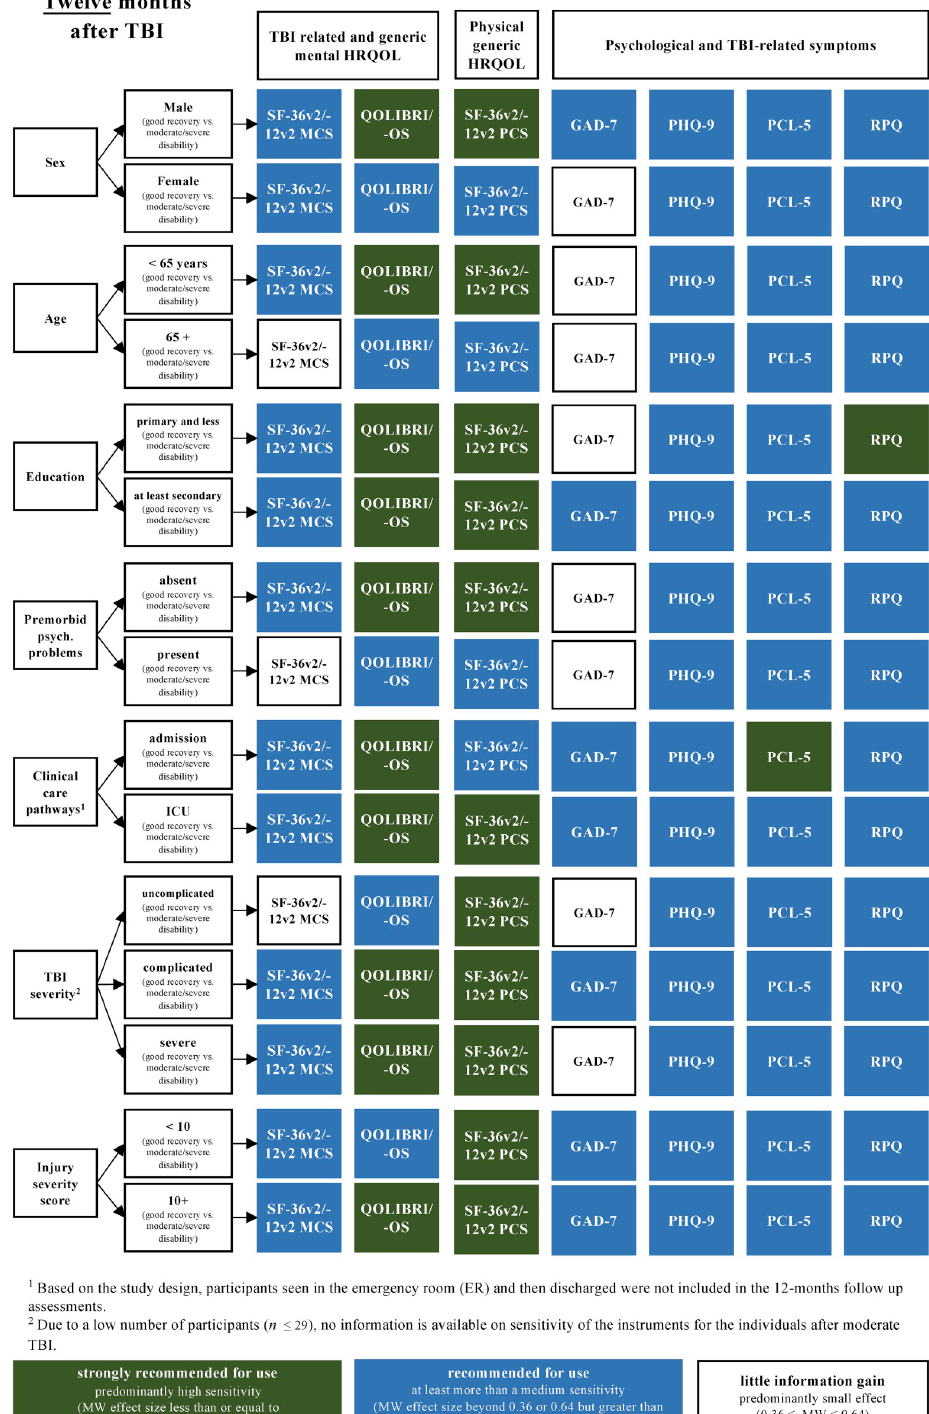
PLOS ONE | https://doi.org/10.1371/journal.pone.0280796 April 7,